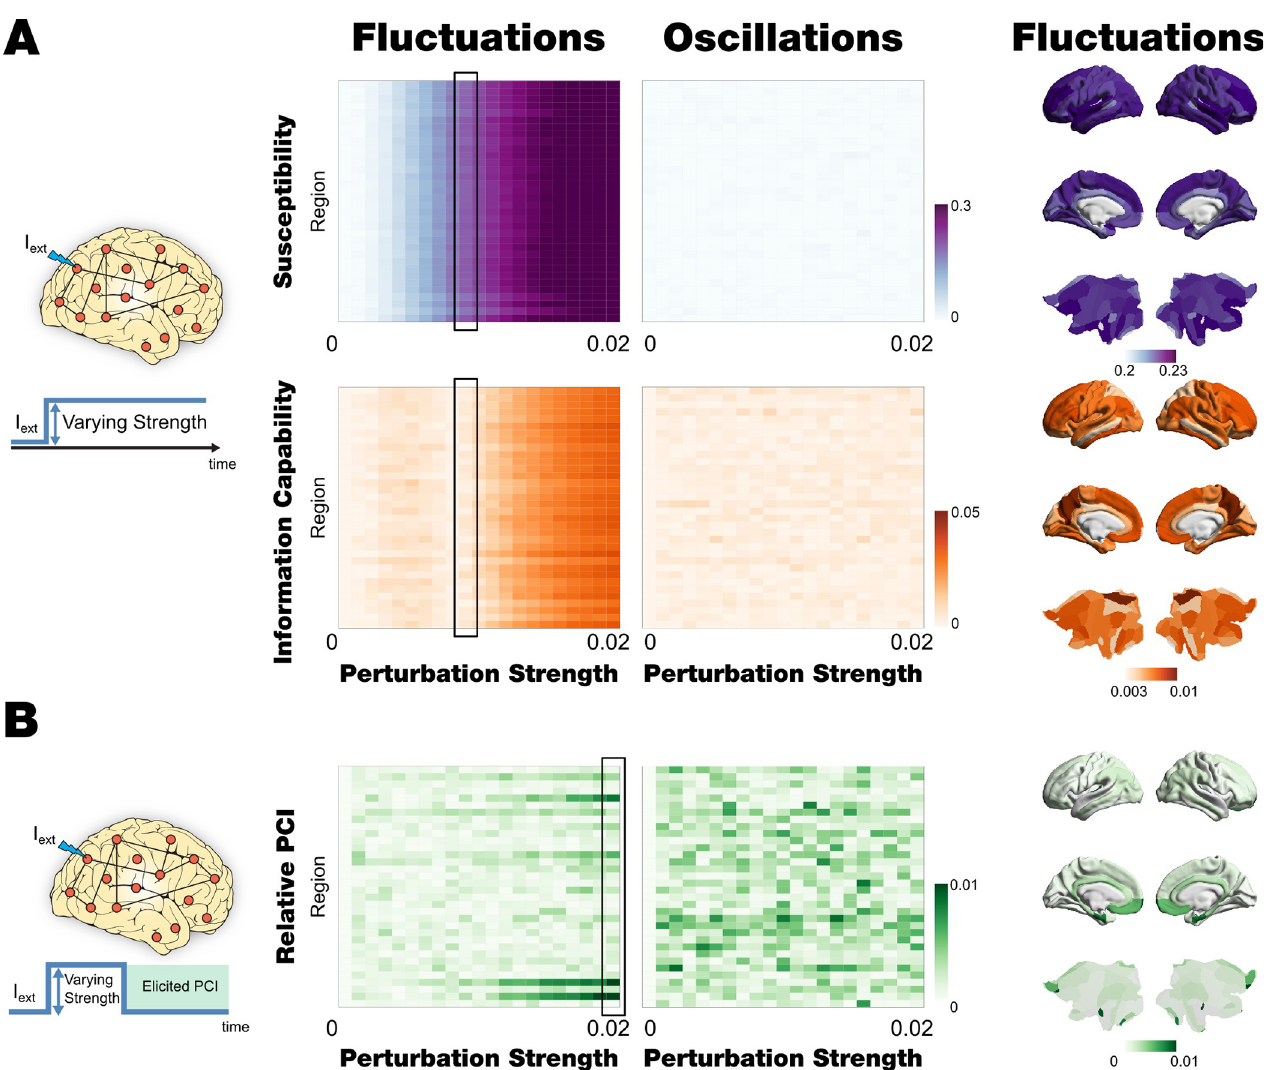
Fig 5. Local and Sustained/non-sustained strength-dependent perturbation. A) The evolution of Susceptibility (first row) and the absolute Information Capability (second row) as a function of the perturbation strength and the perturbed pairs of homotopic nodes. The middle left panel displays the results for the subcritical regime (fluctuations, a = -0.02, G = 2.2 and β = 0), and the middle right panel shows the response of the supercritical regime (oscillations, a = 1.3, G = 0.4 and β = 2.2). The right panels present the perturbative node hierarchy rendered onto the brain cortex for both measures (first and second row) for the case of a perturbation strength of 0.01 indicated with a box in middle left panel. B) Non-sustained PCI: The PCI is obtained by perturbing by pairs of homotopic nodes and different forcing amplitude. In the left column, the PCI results are obtained by perturbing the subcritical model in its corresponding working point with an external periodic force applied by pairs of homotopic nodes as a function of the amplitude of this forcing. In the right column, the same measurement is displayed but, in this case, for the supercritical model in its corresponding working point. The right panel shows the node-perturbative hierarchy in terms of PCI of each region for the maximum value of the forcing amplitude (indicated with black box in the middle-left panel) rendered onto a brain cortex.